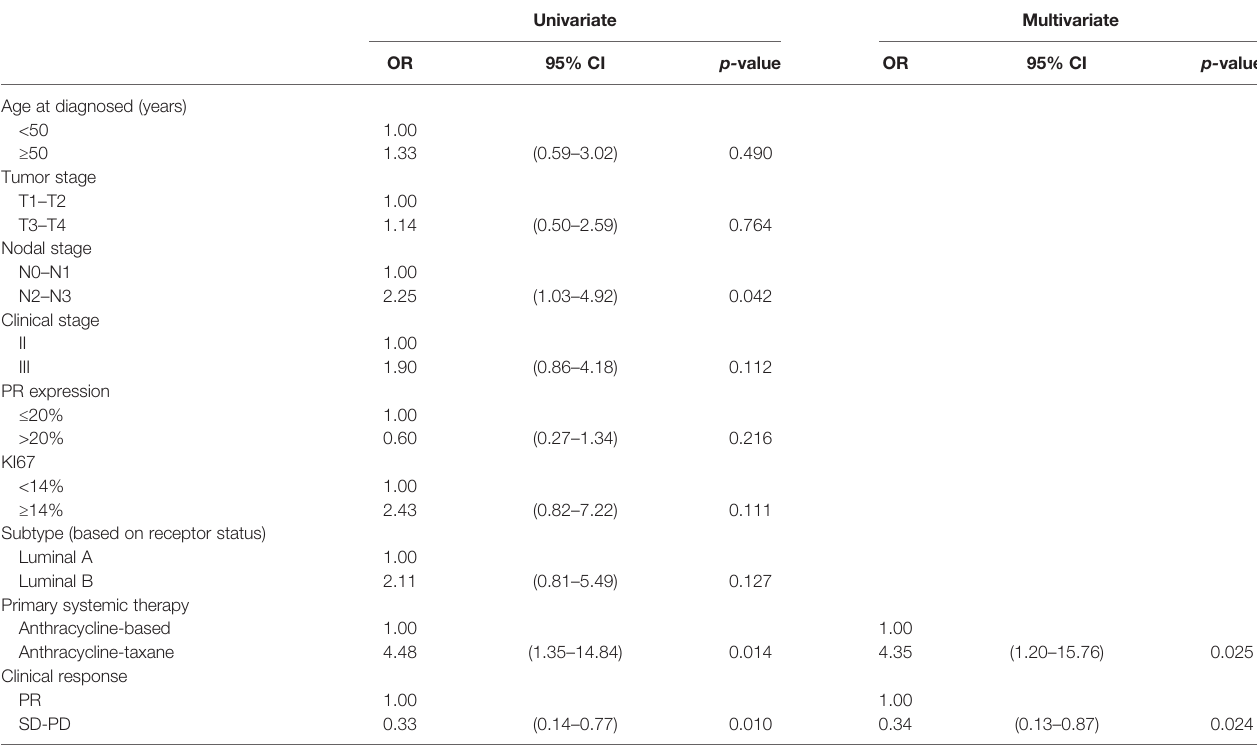
TABLE 3 | Logistic univariate and multivariate analyses for the relationship between clinicopathological characteristics pretreatment and Miller – Payne grades in 105 patients. Univariate Multivariate OR 95% CI p- value OR 95% CI p-